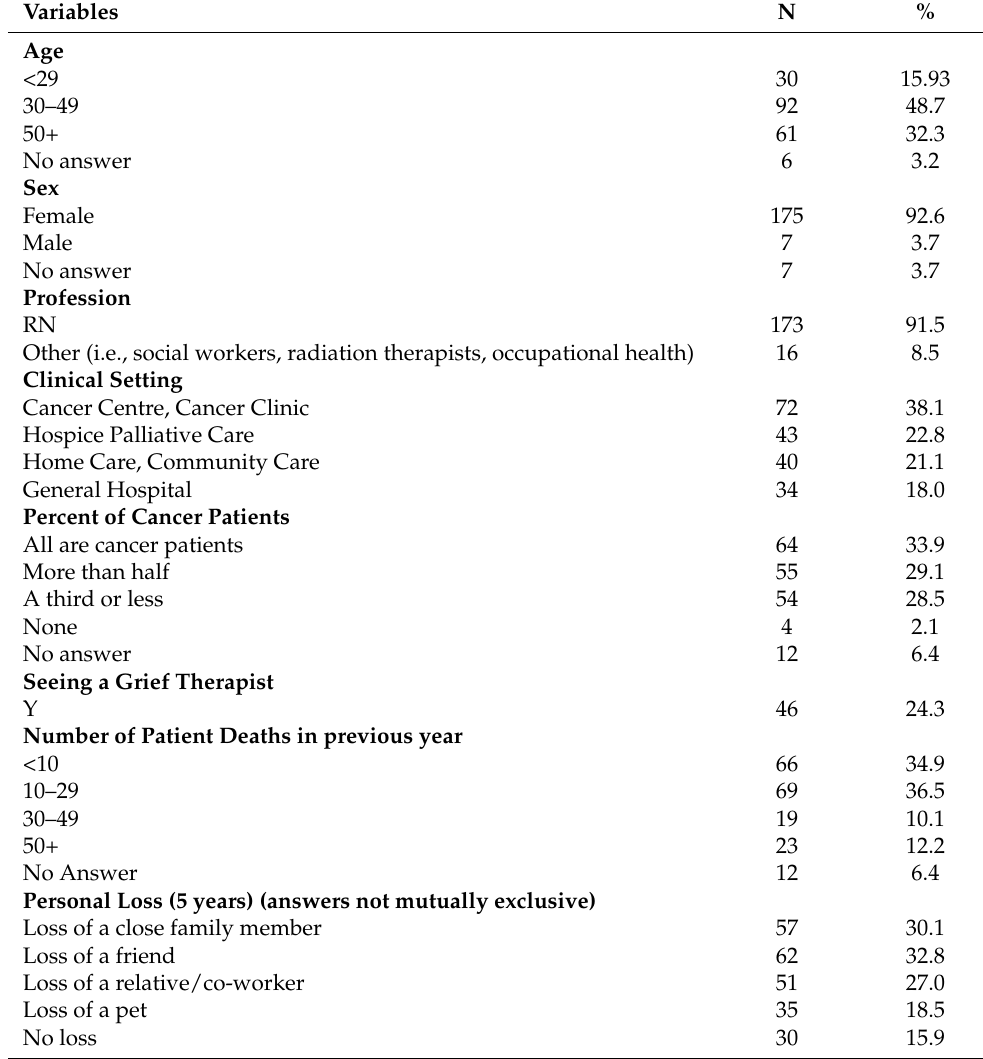
Table 2. Participant characteristics ( n =